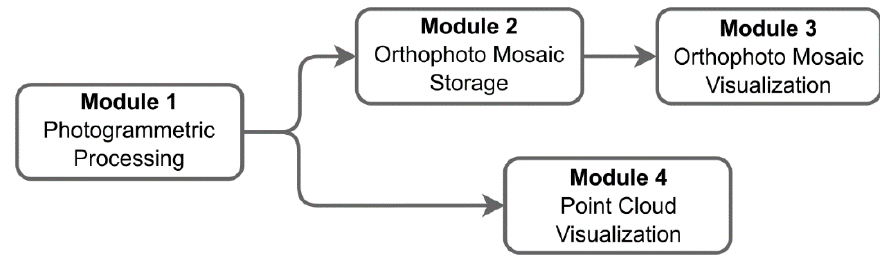
Figure 1. Flowchart of the four modules needed for the conception of the web application.